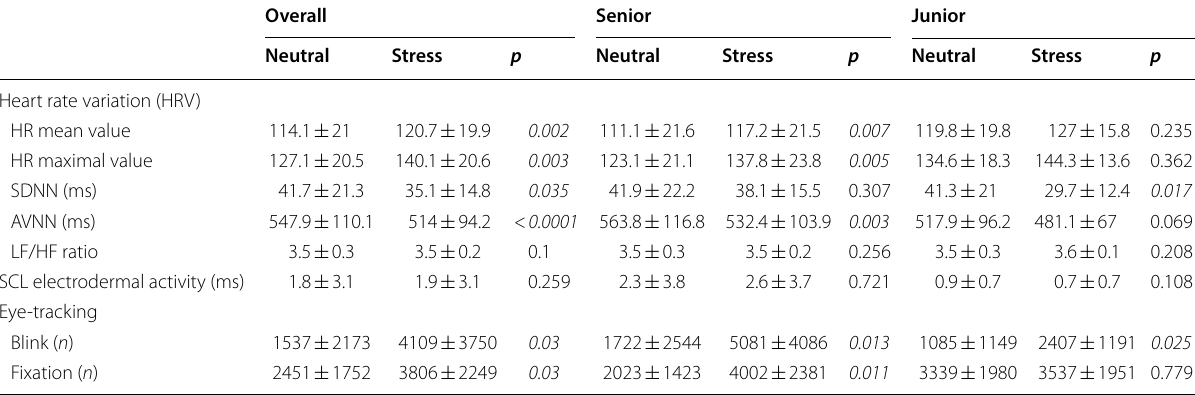
Values are provided as mean STD or number and percentage ± A p value 0.05 was considered statistically significant (in italics) ≤ According to our results, the intubation stress sequence was associated with different HRV parameters, an increase in eye-blinking and fixation episodes in stress condition, as compared to the neutral condition